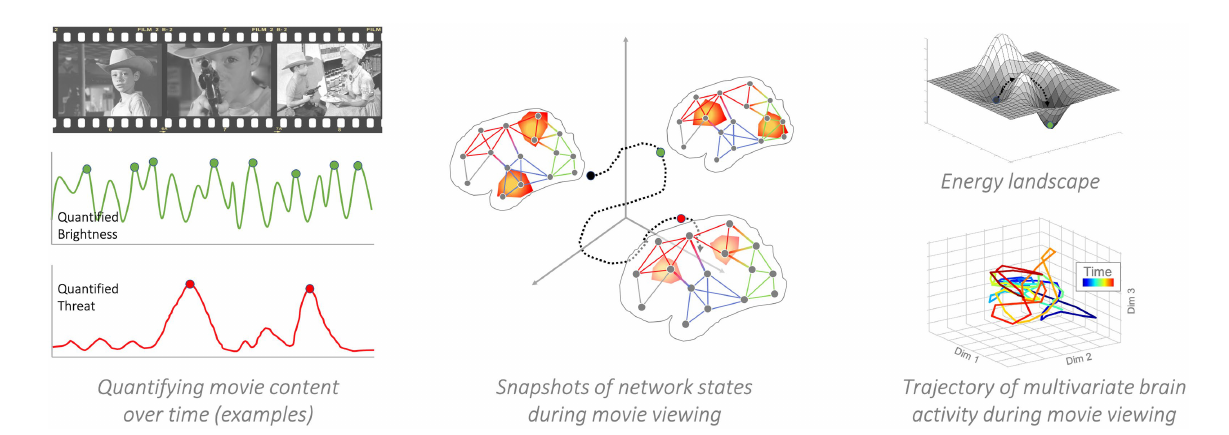
FIGURE 5 Network Control Theory. Left panel: Movie events are the causal forces that push the brain (or brains of entire audiences) into different states. For instance, the sudden reveal of a betrayal will likely engage theory-of-mind processes associated with social-cognitive brain networks. The depiction of a potential shooter approaching an innocent victim will engage affective systems. In this particular example, brightness and threat could be used as a time varying energetic source to use in a control theoretic analysis. The idea being, that each is analogous to an energetic source that should impact specific nodes (visual cortex, PFC, respectively) differently, and have different cascading impacts on time-varying network topology. Middle panel: A snapshot of network states in a single individual. As the individual views the movie, their brain responds to the time-varying content. Visual changes will prompt visual networks to come online and reconfigure (the example focuses only on brightness, but other visual features could be modeled, such as the presence or number of faces, contrast, objects, etc.). In parallel, higher-level content elements (though conveyed via the concrete sensory- perceptual features) prompt changes in networks related to executive control, salience processing, etc. Right panel, top: Example of an energy landscape in which valleys represent equilibrium states. By application of control energy, the brain can be pushed to leave one state and settle down in another. Note that the actual landscape has a higher dimensionality. Right panel, bottom: Example of a multivariate brain activity trajectory from actual movie-viewers. The input movie was Bang-Bang! You’re dead by Alfred Hitchcock. Brain activity from different regions (268-dimensional) is embedded in a lower-dimensional (3-dimensions) space (Heusser et al., 2018). Color represents time. As can be seen, the time-varying movie content steers brain activity into different